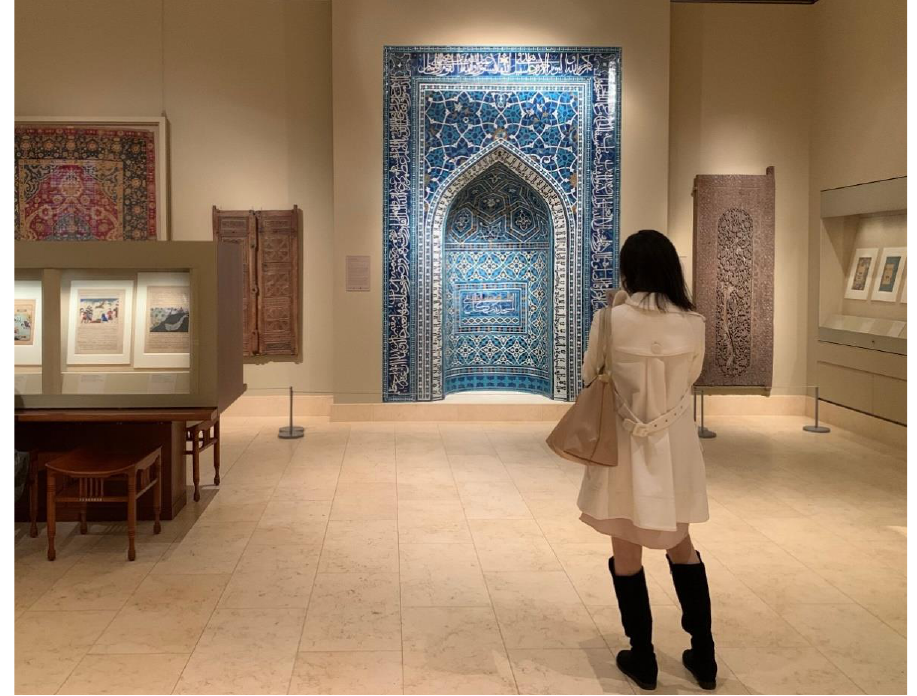
Figure 13. View of the gallery of “The Art of the Arab Lands, Turkey, Iran, Central Asia and Later South Asia”, Metropolitan Museum of Art, New York. Photo in public